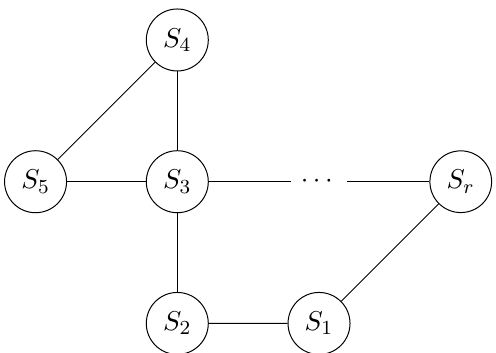
Figure 1. Graphical representation of a rank r K(cid:127)ahler surface S = local Calabi-Yau 3-fold X . The nodes of the graph correspond to 4-cycles S i , while the edges C i;i +1 = S i S i +1 correspond to 2-cycles along which the nodes \